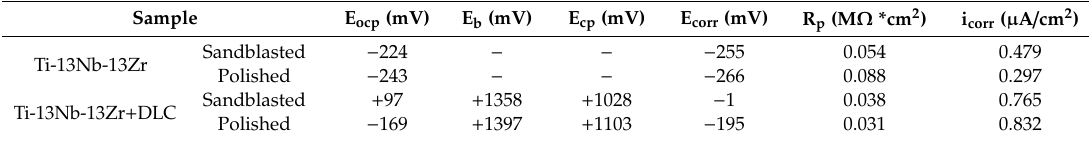
Table 4. Results of potentiodynamic tests.